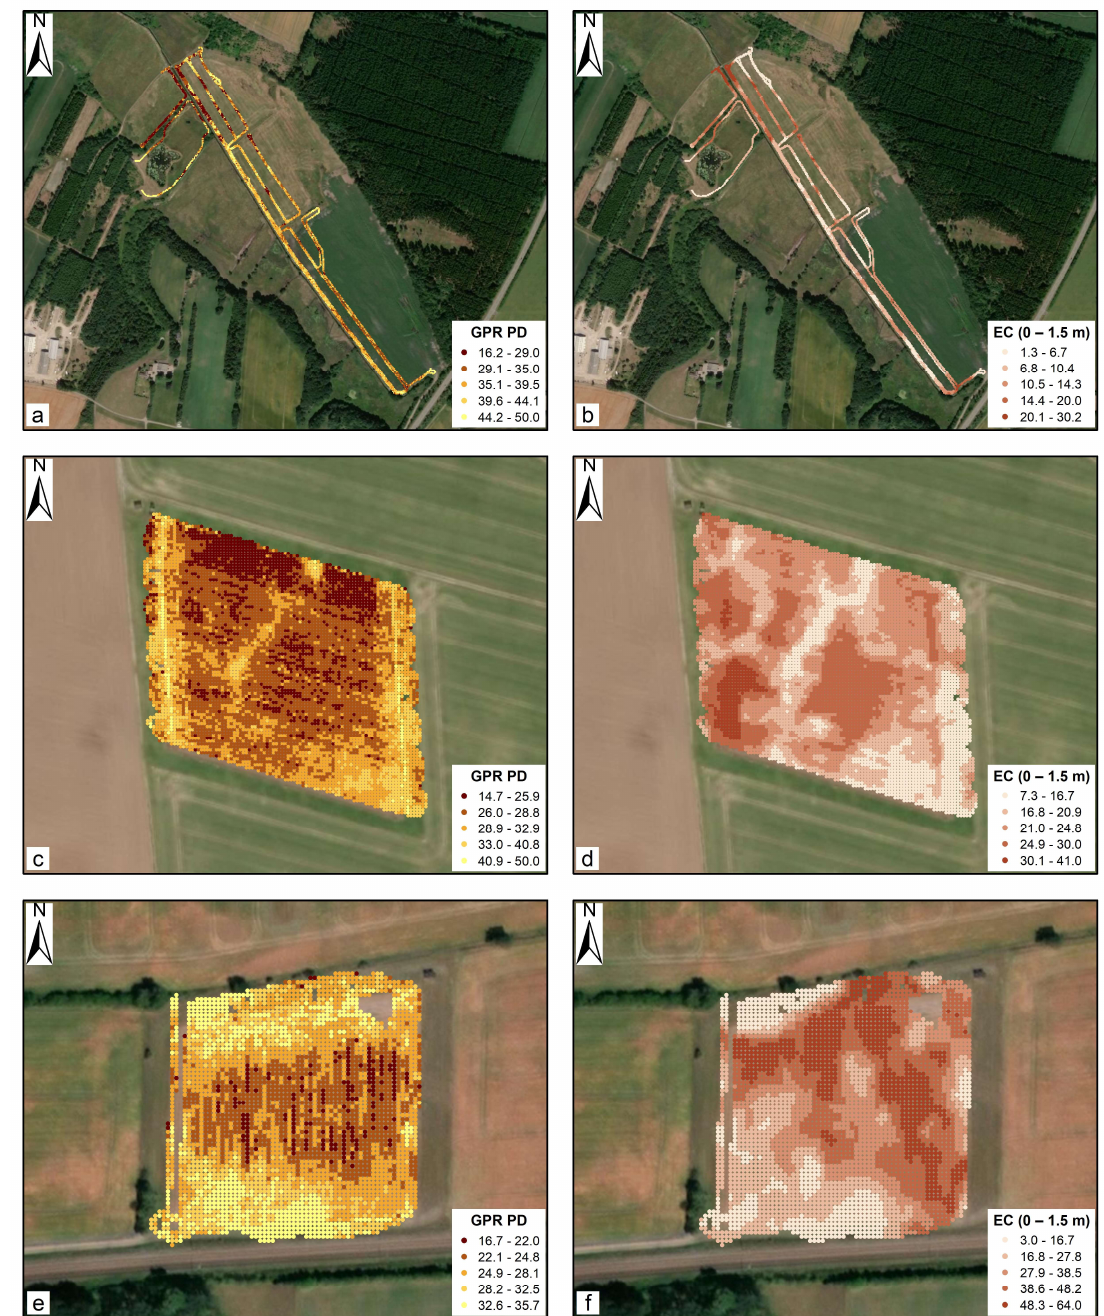
Figure 12. Maps showing the comparison between the 3D-GPR localized penetration depth (ns) and EC (0–1.5 m, mS m − 1 ) at Holtum ( a , b ), Faardrup ( c , d ), and Estrup ( e , f ). The color bar definitions